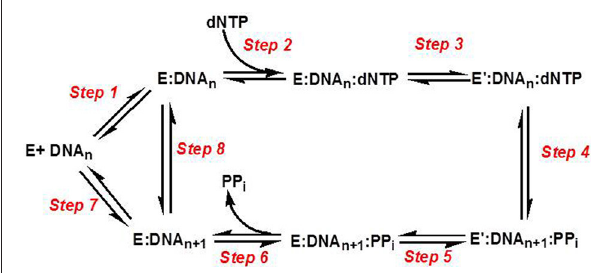
FIGURE 3 | Kinetic mechanism for DNA polymerases. Individual steps along the pathway for DNA polymerization are numbered and identified as described in the text. E, polymerase; DNA n , DNA substrate; E ′ , conformational change in DNA polymerase; PP i , inorganic pyrophosphate; DNA n + 1 , DNA product (DNA extended by one nucleobase).